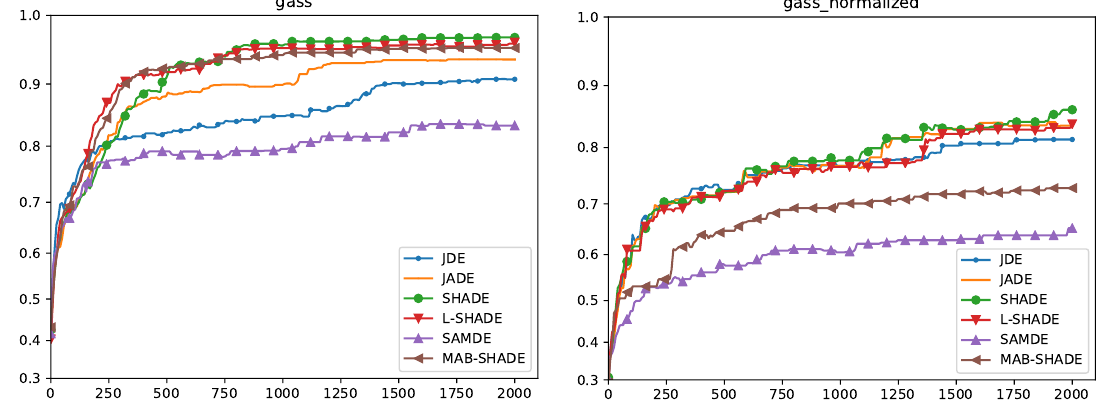
Figure 3. Plots of convergences on GASS and GASS normalized datasets.